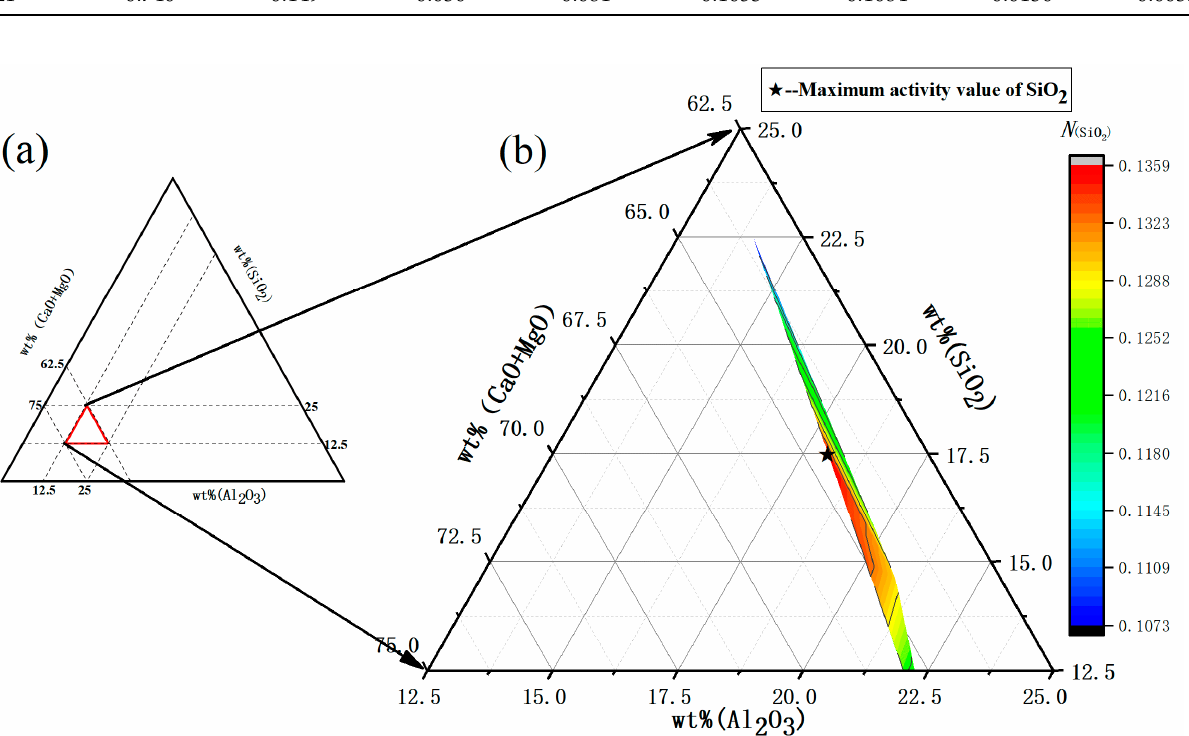
Figure 2. ( a ) Slag composition of the (CaO + MgO)-SiO 2 -Al 2 O 3 pseudo-ternary system. ( b ) Model predicted values: effect of SiO 2 content on SiO 2 activity in refining slag. predicted values: effect of SiO 2 content on SiO 2 activity in refining